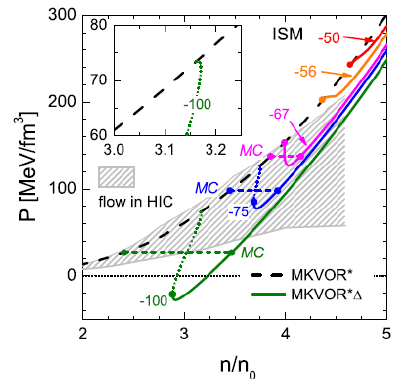
Figure 6. Figure from [11]. Pressure as a function of the density in the ISM for MKVOR* model (dashed line) and MKVOR* ∆ model (dotted and solid lines). The hatched region indicates the nucleon flow constraint [2] in heavy-ion collisions. MC lines indicate the Maxwell